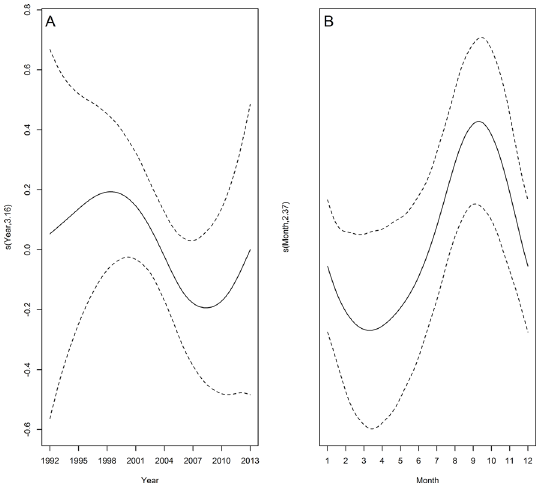
Fig 7. Temporal trends in South American sea lion strandings. Estimated smooth function (solid line) with 95% confidence interval (dashed lines) for the fitted GAM by year (A) and month (B) from 1992 to 2013. Y-axis = fitted function with estimated degrees of freedom in